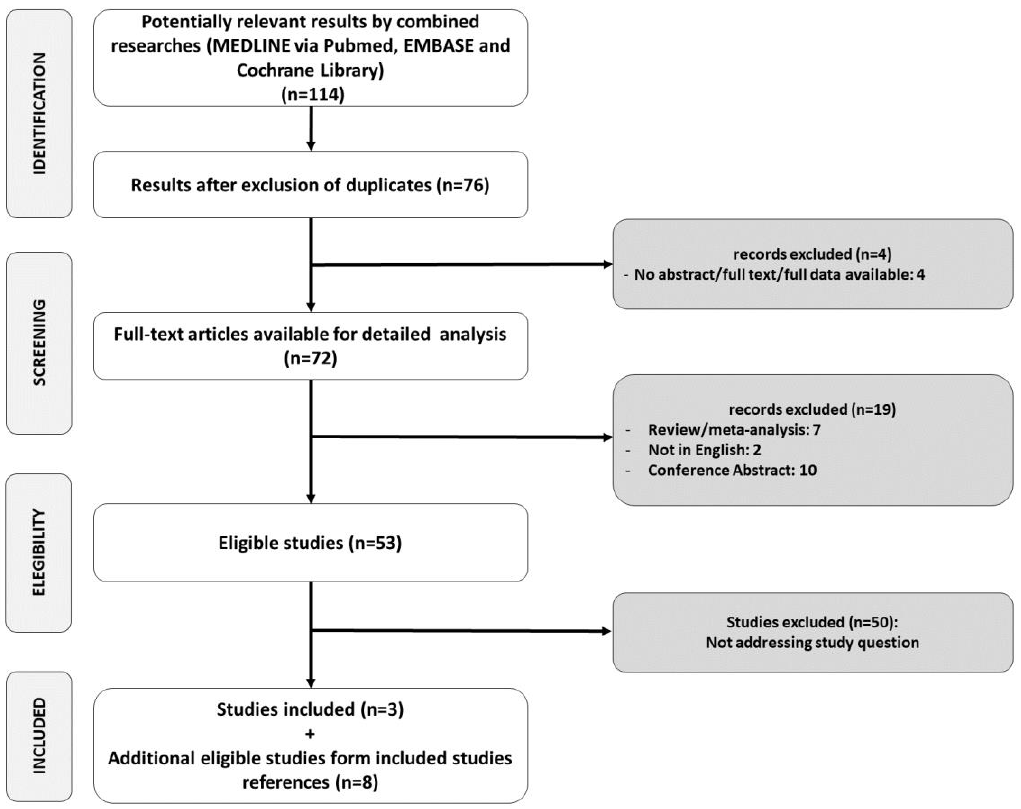
Figure 2. Study selection.